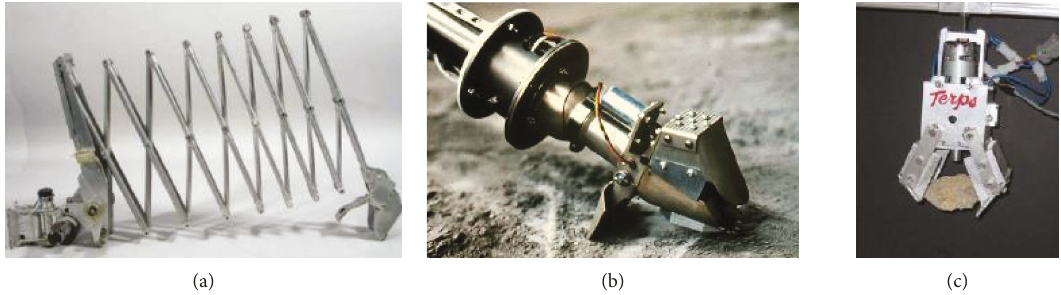
Figure 1: Various surface sampling equipment structures: (a) digging, (b) shovelling, and (c)